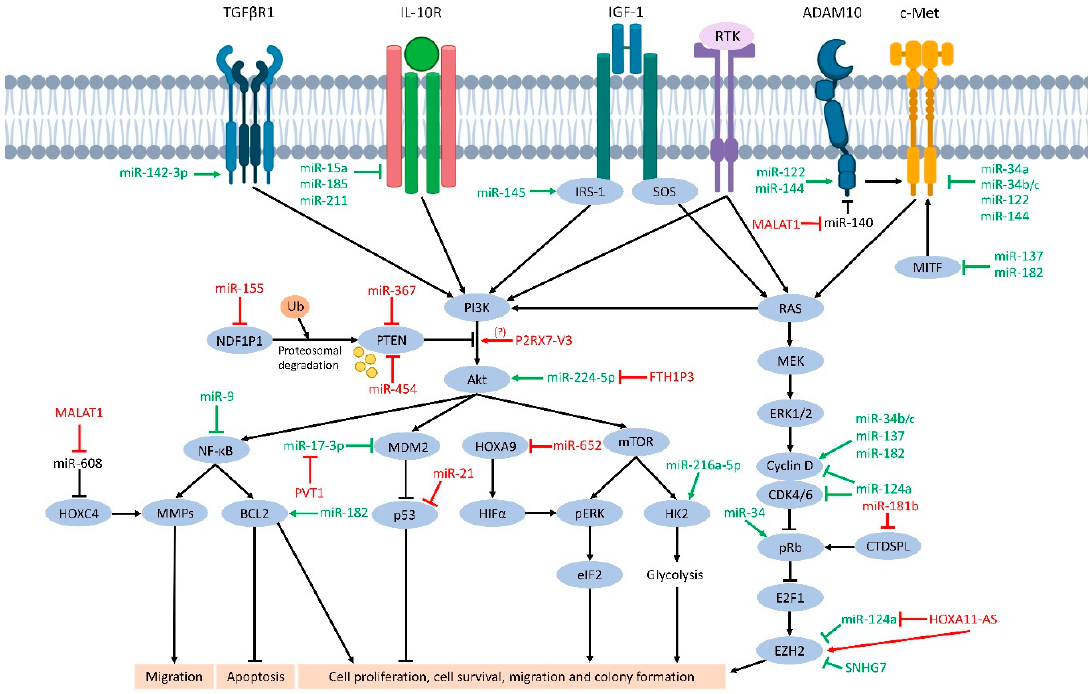
Figure 2. The impact of ncRNAs-mediated PI3K / AKT and MAPK / ERK pathway in uveal melanoma (UM). The ncRNAs that have a suppressive role are colored green, while the oncogenic ncRNAs are colored red.